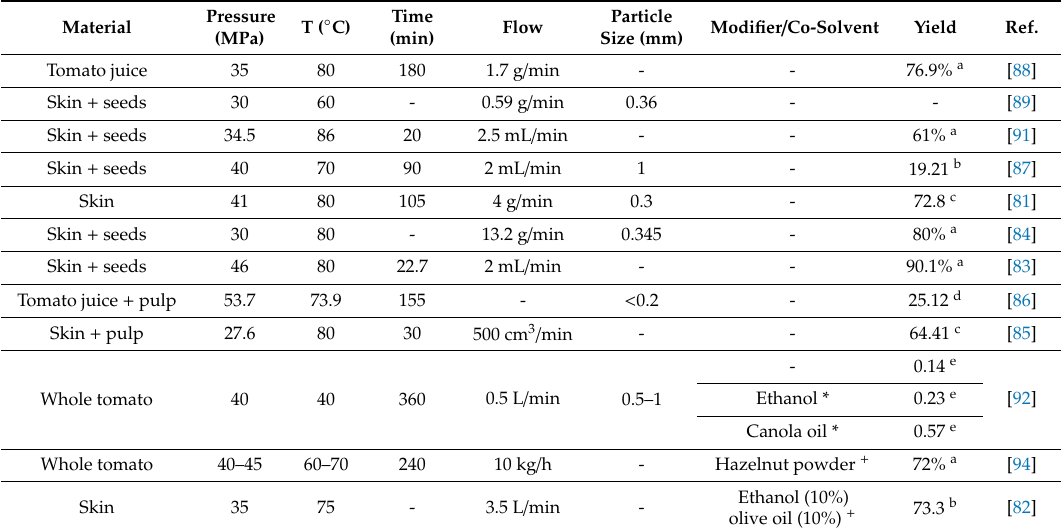
Table 2. SFE-CO 2 conditions applied in recovering carotenoids from tomato